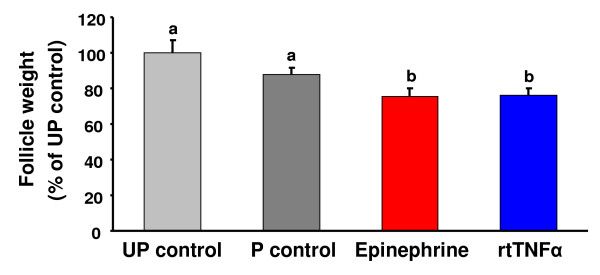
Effects of rtTNFα treatment in vitro on follicle contraction in brown trout preovulatory follicles. Preovulatory brown trout ovarian follicles were incubated for 16 h at 15°C in the presence or absence of the test compounds epinephrine and rtTNFα. Each bar represents the mean ± SE from three independent experiments, each performed with preovulatory follicles from a different female and assayed in triplicate. The results are expressed as percent change with respect to the unpunctured control group (UP control) which has been set at 100%. Punctured (P) trout preovulatory ovarian follicles were incubated in the absence or presence of epinephrine (10 μM) or rtTNFα (50 ng/ml). Statistically significant (p < 0.05) differences among groups are indicated by different letters.